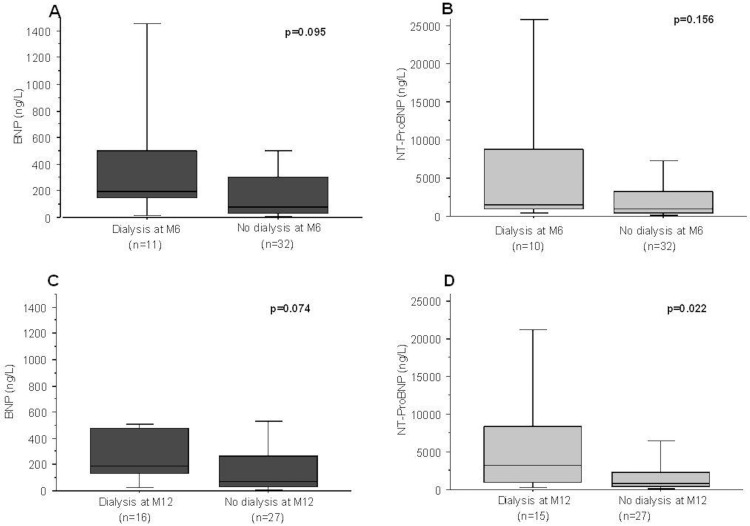
BNP (A, C) and NT-proBNP (B, D) values according to the initiation of dialysis after 6 (A, B), and 12 months (C, D) follow-up.The upper and lower limits represent the interquartile range (Q1-Q3) and the middle line of the box-plot represents the median. Differences between the groups were analyzed using the Mann-Whitney U test.